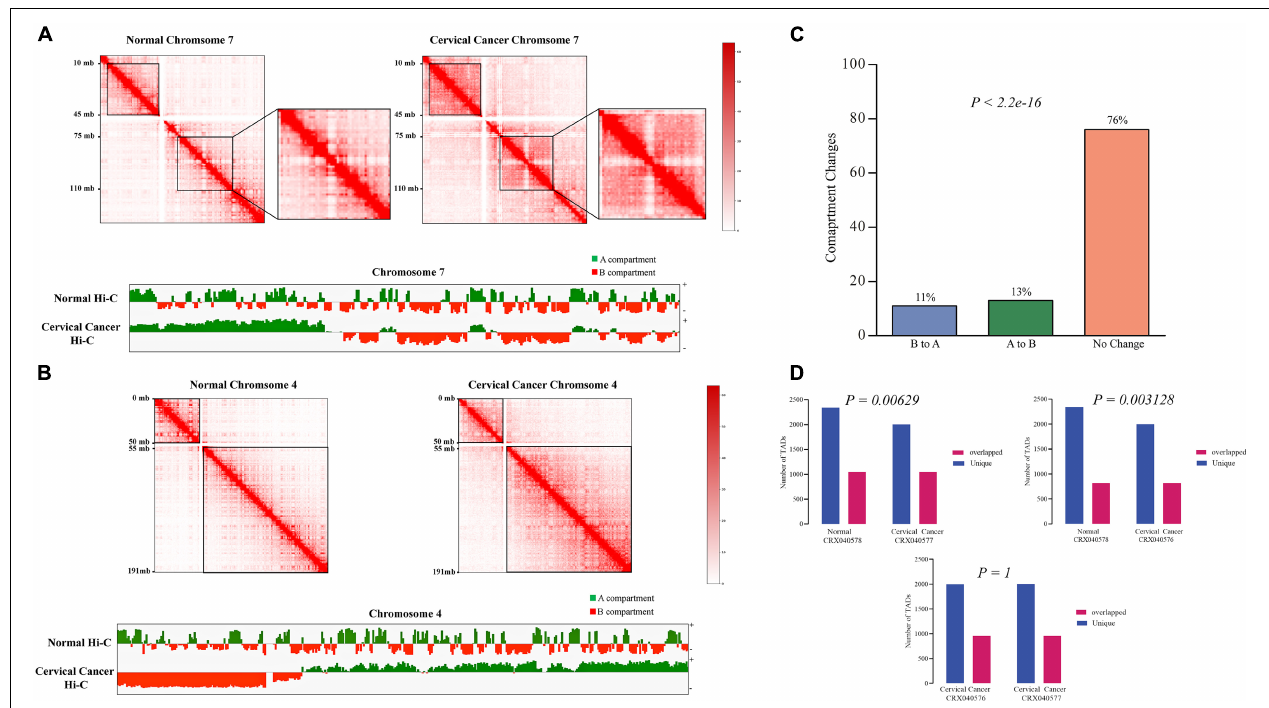
FIGURE 2 | Comparative Hi-C data revealing the genome architecture changes at chromosomal level. Differential chromosomal architecture. (A,B) Comparison of chromatin interaction heatmaps from chromosomes 7 and 4 between normal (left panel) and cervical cancer (right panel) tissues. Variable regions are highlighted with the black boxes. Interaction maps are shown at 500 kb resolution. A/B compartment switching between normal and cervical cancer tissue was detected at 500 kb resolution using juicer-eigenvector. Values greater than 0 were assigned as A compartment (green color), and values less than 0 were designated as B compartment (Red color). (C) A/B compartment changes between normal and cervical cancer tissue data. Bar-graph representing overall compartment switching, orange: conserved compartments, green: A to B compartment conversion, and sky blue: B to A compartment change. (D) Bar-graphs show the comparison of the number of TADs found in cervical cancer and normal Hi-C data. Purple: TADs found in normal tissues, red: cervical cancer data in CRX040576 experiment, and blue: TADs found in cervical cancer tissue CRX040577